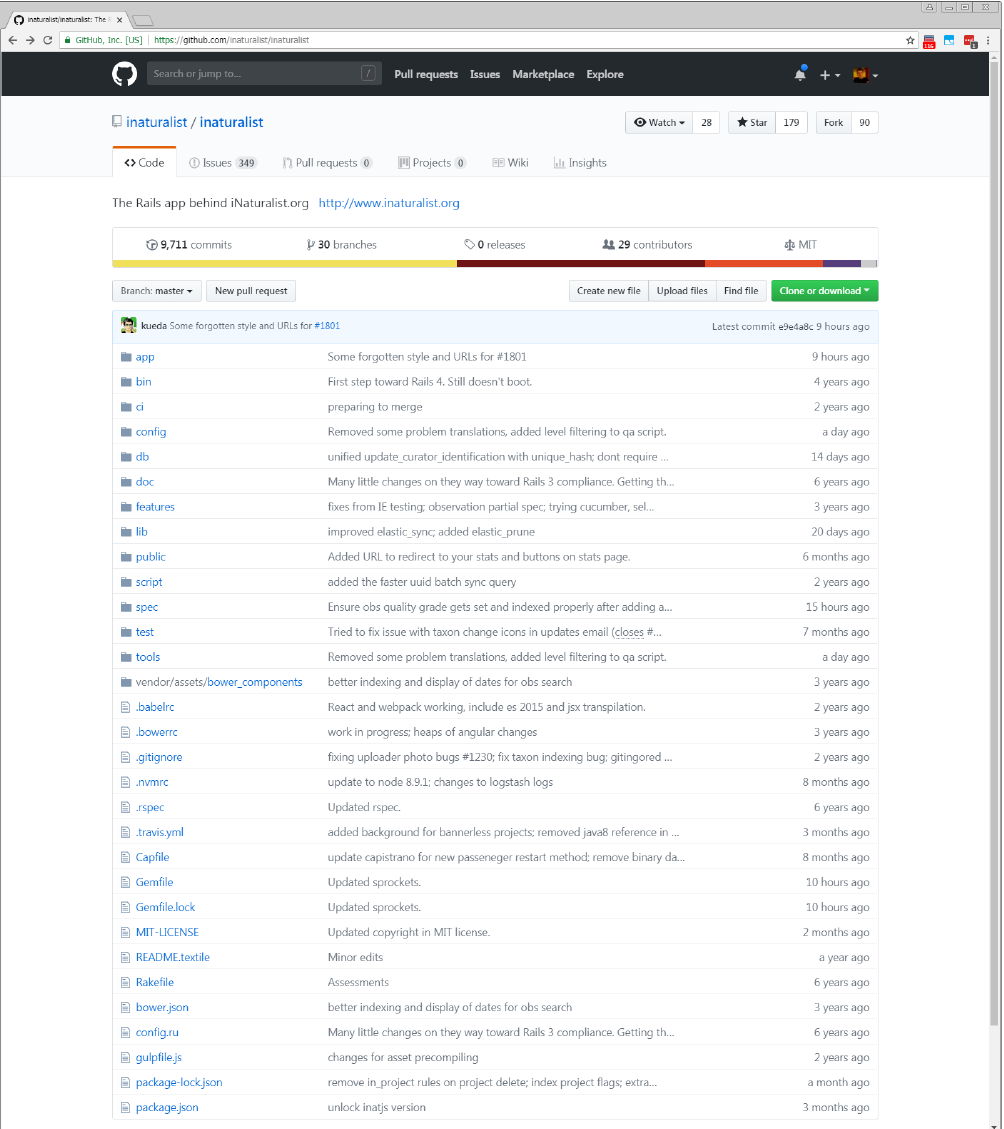
Figure 4 – The source code for iNaturalist in